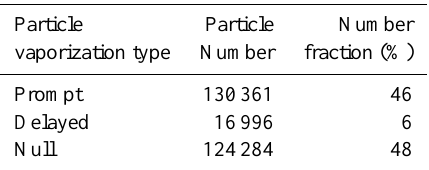
Table 2. Particle number and number fraction for the three vapor- ization